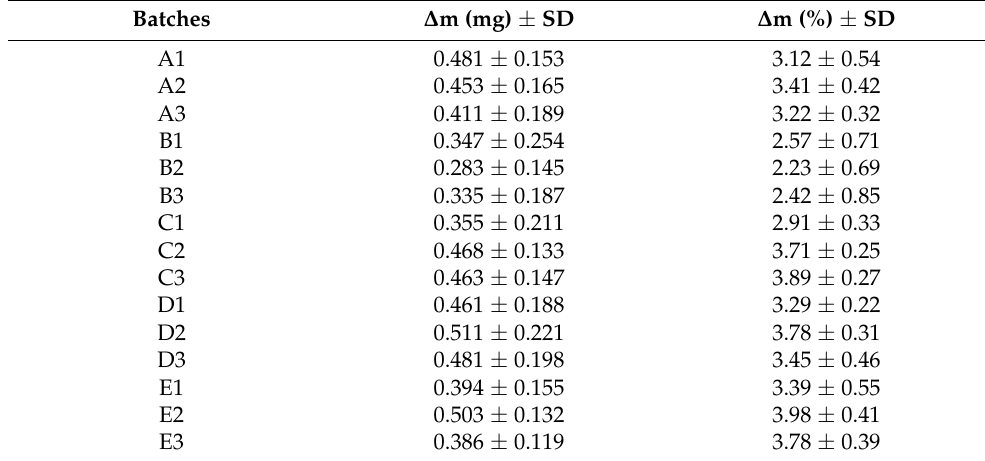
Table 4. Overall, the batches of microparticles showed a slight increase in residual humidity, but no visible degradation phenomena. Only batches with β -carotene (B1, B2, B3) had statistically different lower values compared with each of the other vitamins. Table 4. Mass variations ( ∆ m) as mg and percentage ± SD (mean ± SD, n = 3), calculated by thermogravimetric analysis of all microparticle batch samples (A1, A2, A3, B1, B2, B3, C1, C2, C3, D1, D2, D3, E1, E2, E3), carried out 6 months after their production. Batches ∆ m (mg) ± SD ∆ m (%) ± SD 0.481 ± 0.153